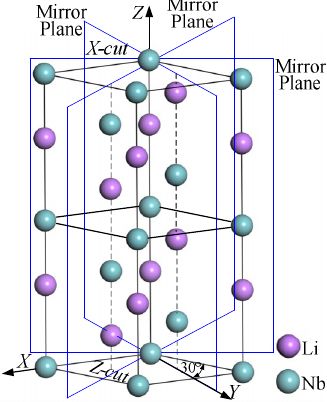
Figure 11. Slip orientations (X axis) in LN cell unit.